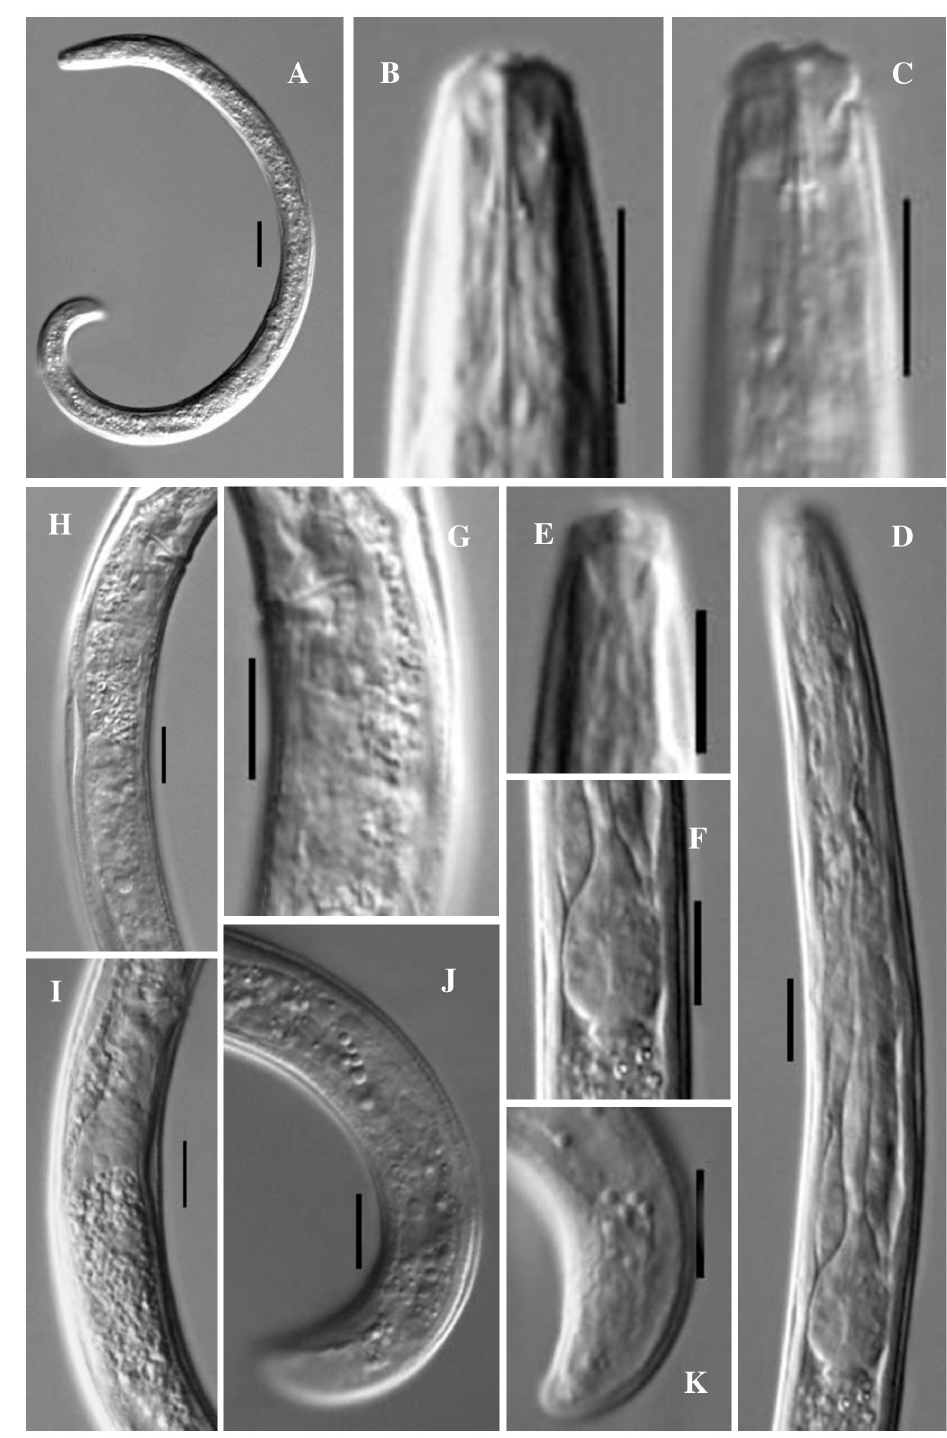
Fig. 17. Basirotyleptus siddiqii sp. nov., ♀ (LM photographs). A–B, E, I–K . Holotype (AMU/ZD/ NC/ Basirotyleptus siddiqii /1). C–D, F–H . Paratype 1 (AMU/ZD/NC/ Basirotyleptus siddiqii /2). A . Entire specimen. B–C . Anterior region. D . Pharyngeal region. E . Anterior region showing amphid. F . Pharyngeal bulb. G . Vulval region. H–I . Genital system. J . Posterior region. K . Posterior end. Scale bars: A = 20 µm; B – K = 10